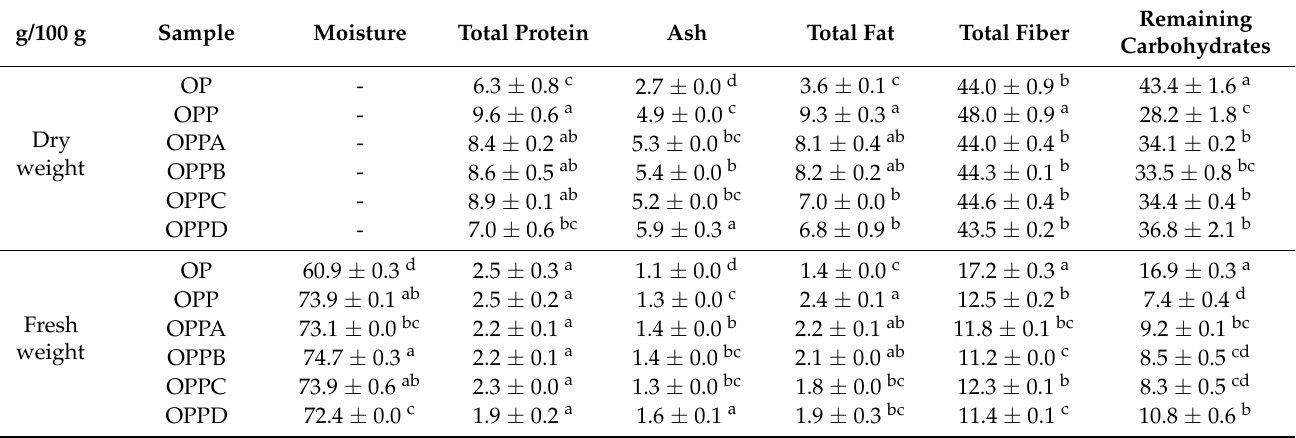
Table 1. Proximate composition of olive pomace